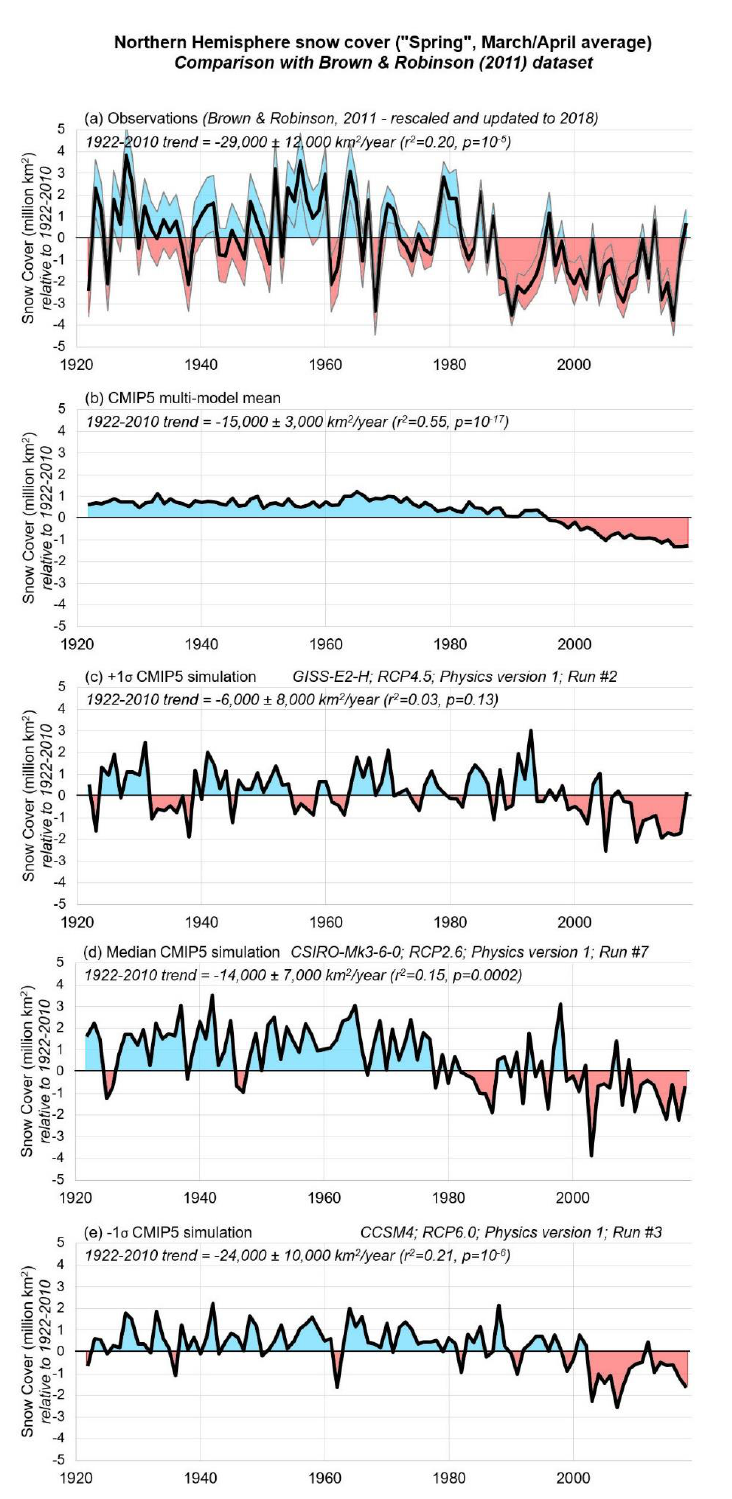
Figure 9. As for Figure 4, except for the updated Brown & Robinson (2011) March/April “Spring” estimate, and covering the period 1922–2018.